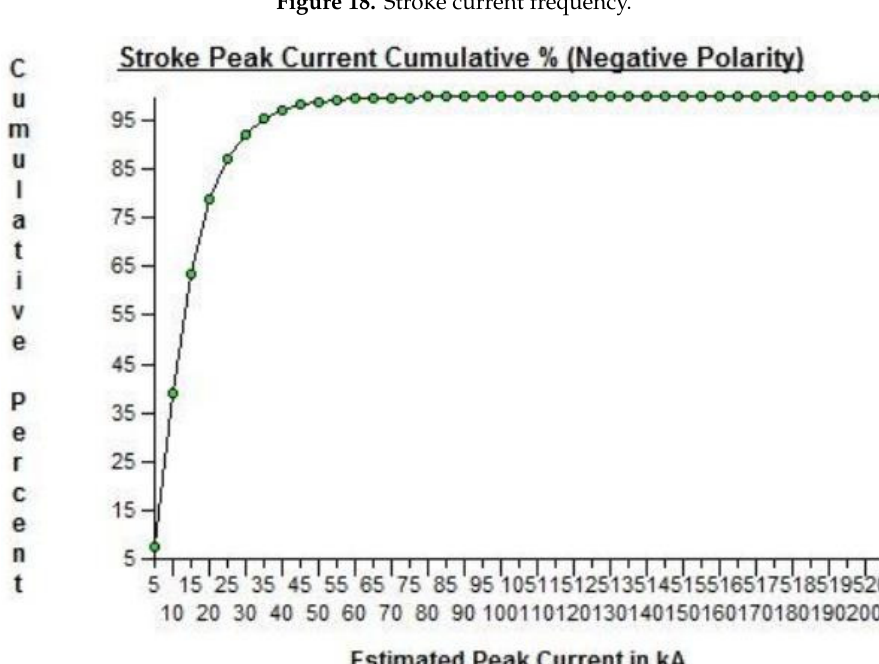
Figure 19. Accumulative stroke percentage.